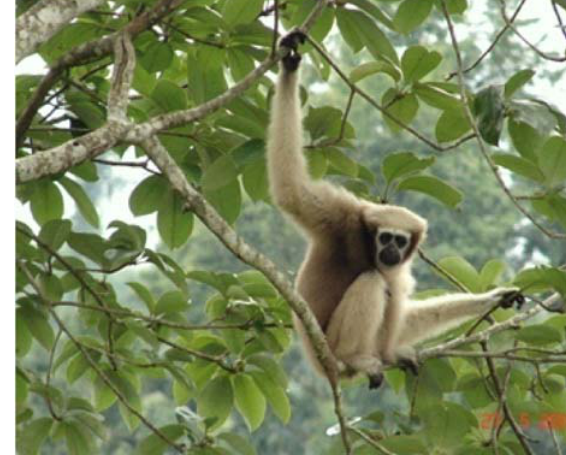
Image 3. Pregnant female gibbon.